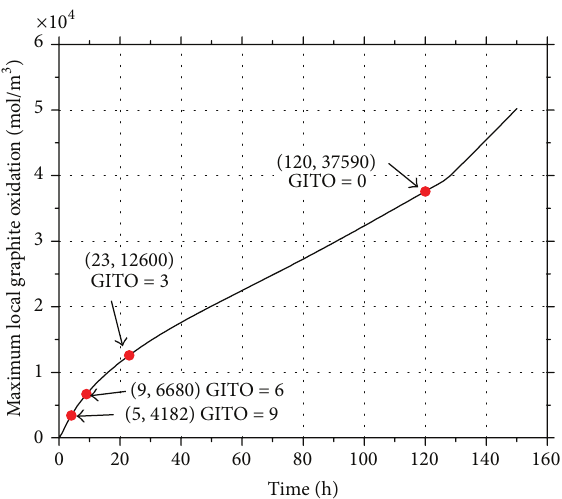
Figure 4: The maximum local graphite oxidation in the core.